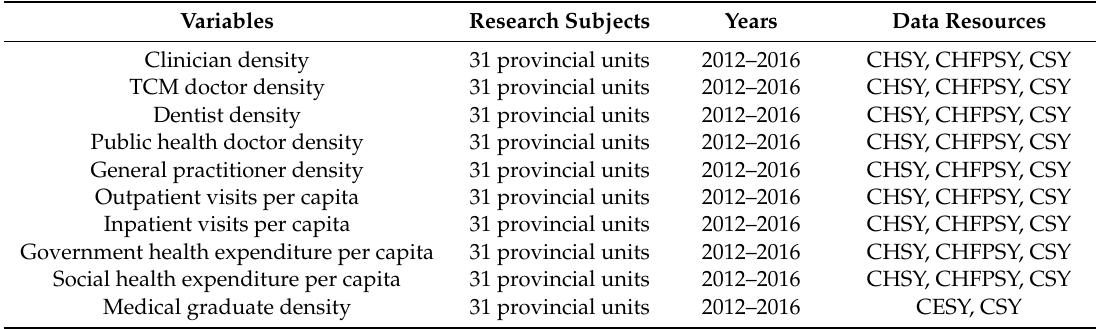
Table 2. Variables and data